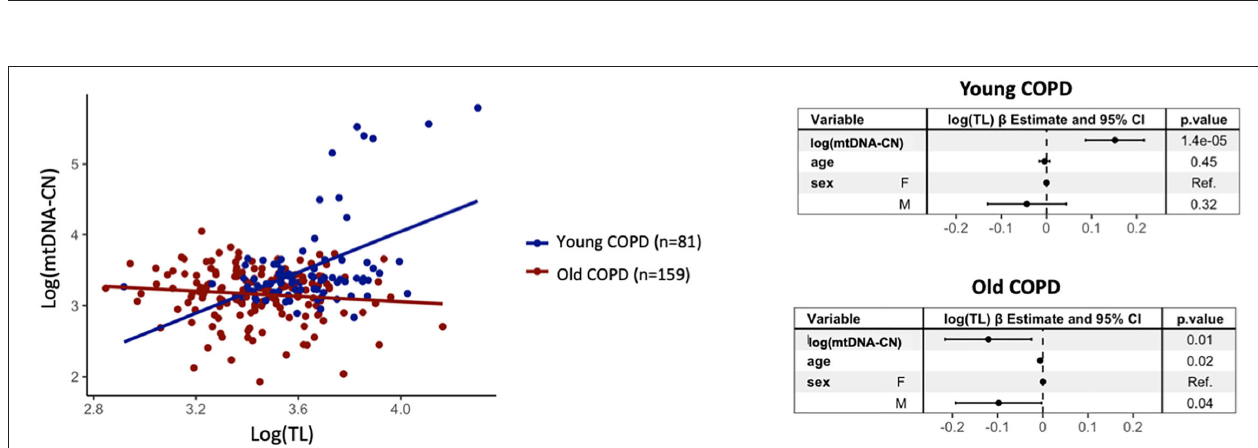
FIGURE 5 | A scatter plot of log(TL) vs. log(mtDNA-CN) in young ( n = 81) (dark blue dots) and old ( n = 159) (red dots) patients with COPD, and the corresponding forest plots of the linear regression model estimates. For further explanations, see text.